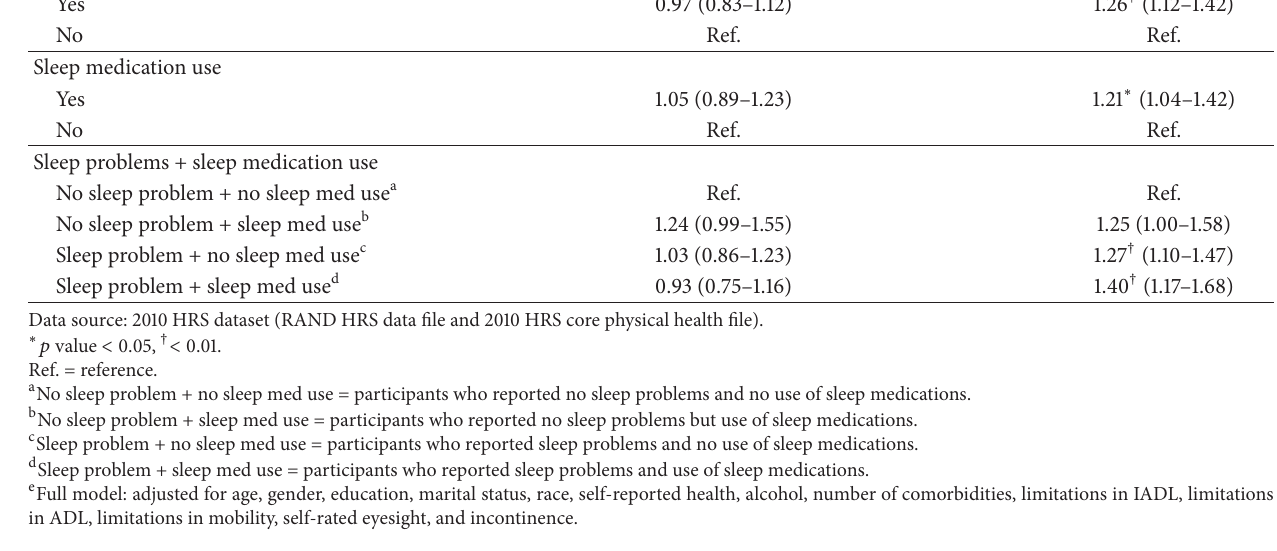
Single fallers Recurrent fallers Adjusted OR (95%